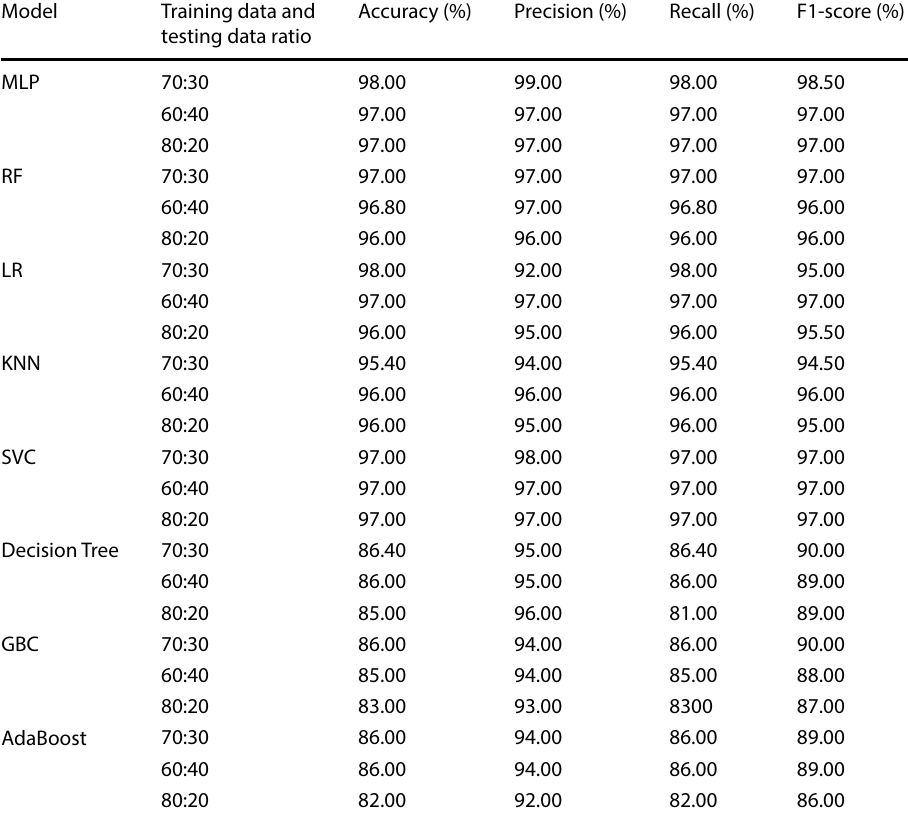
features, MLP and LR each perform better than other classifiers. Highest performance comparison of different classification algorithms on top 15 features is shown in Fig. 5. Performance comparison of different classification algorithms on top 15 features based on various dataset splitting ratio is shown in Table 3.